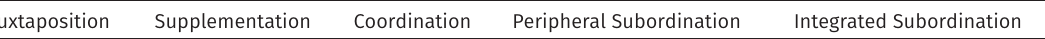
Table 1: The continuum of clause combining in